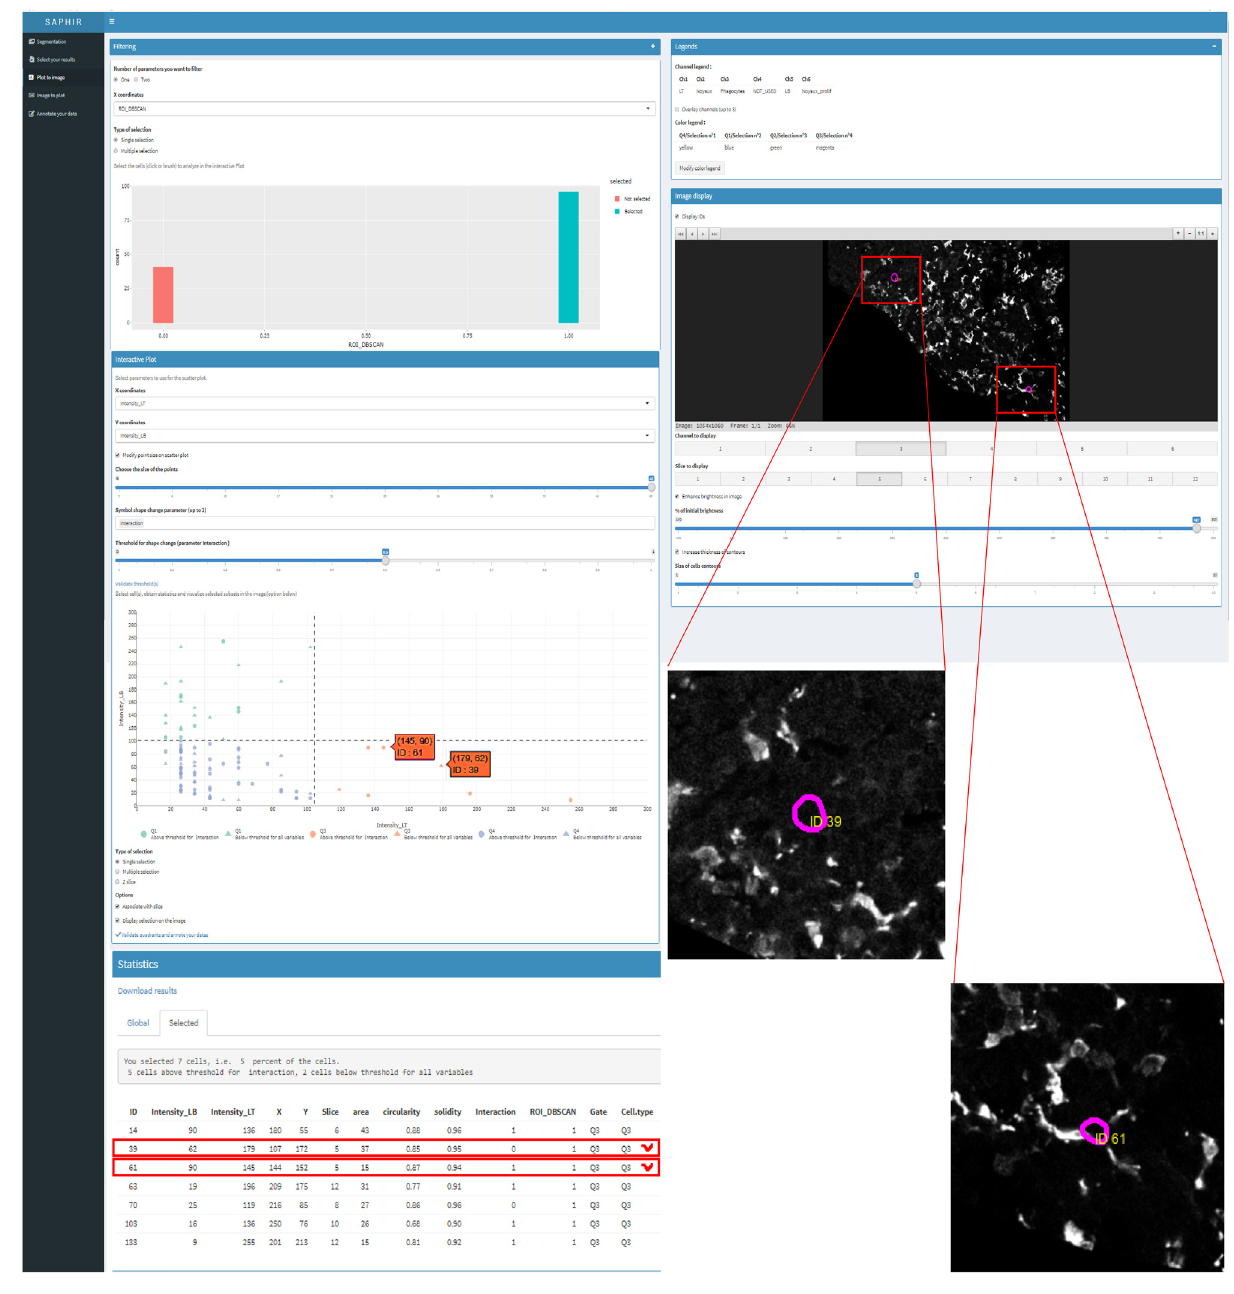
Figure 6. Use case: analysis of proliferative immune effector cells interacting with phagocytes in the T cell zone of murine Peyer’s patches. Upper left: Proliferative cells belonging to the proliferative area of the T cell zone periphery (ROI_DBSCAN) were selected using the Filtering tab (green rectangle). Mid-left: ROI proliferative cells were split into T (orange symbols) and B cells (green symbols) on the scatterplot and phagocyte-interacting cells highlighted (circles) thanks to the symbol shape change parameter. Right: Proliferative T cells selected in the lower left scatter plot were visualized on each optical section (magenta contour). On the shown optical section two proliferative T cells were observed. Higher magnification of the boxed area showed phagocytes (grey cells) interacting with one proliferative T cell (ID 61) but not with the other (ID39). T cell ID numbers allow to locate them back in the scatterplot (pointed out in orange) and in the statistical table (boxed in red) and to check that one but not the other was indeed identified as interacting with phagocytes (circle vs triangle in the scatterplot and 1 vs 0 in the interaction